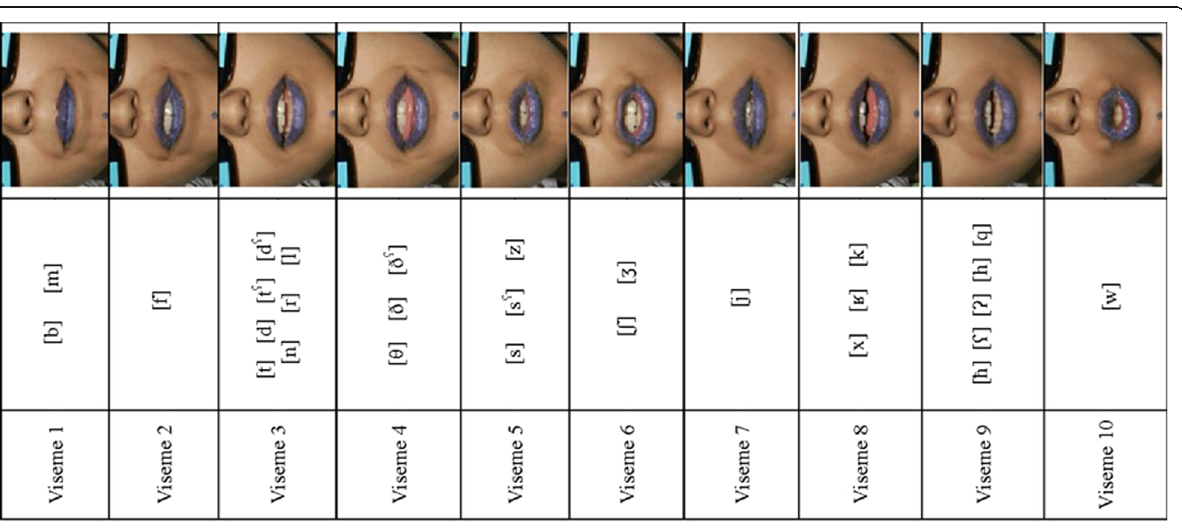
Fig. 1 The visemes classifcation of the Modern Standard Arabic language. The source is